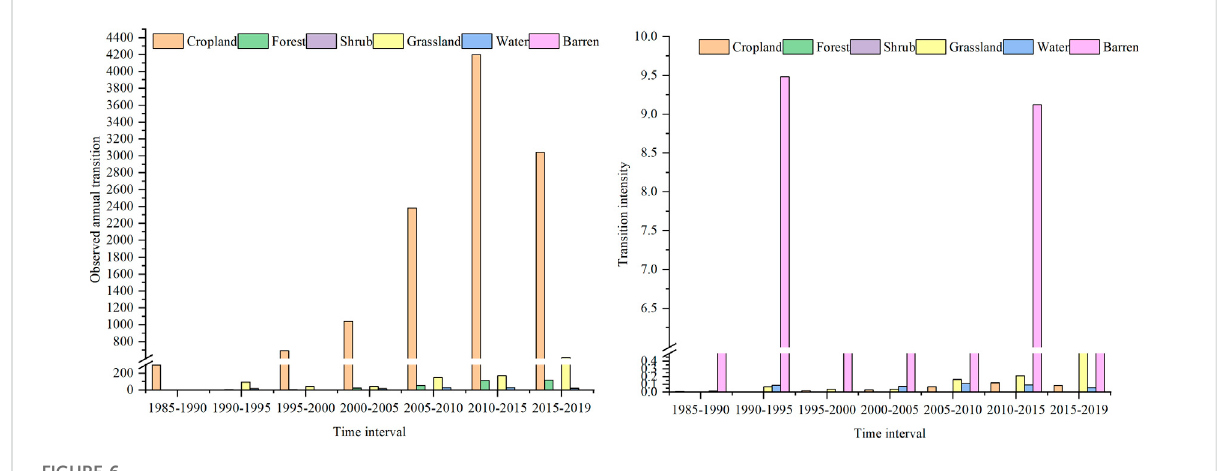
FIGURE 6 Transition from other land use types to impervious land in the transition level.